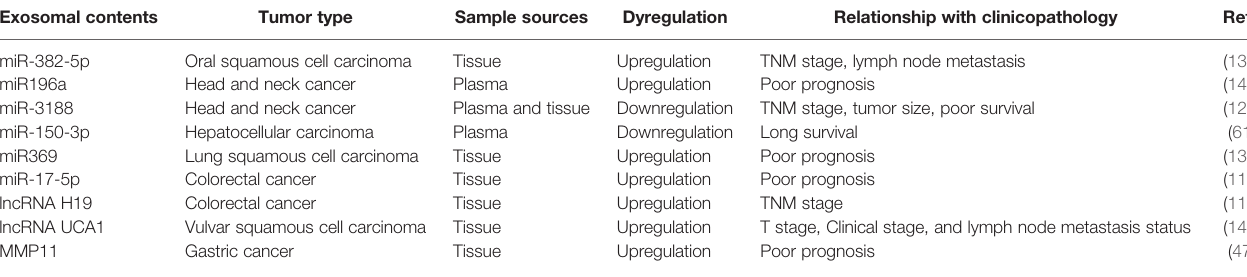
TABLE 3 | Correlation between CAF-derived exosomal content and clinical pathological characterizations of cancer